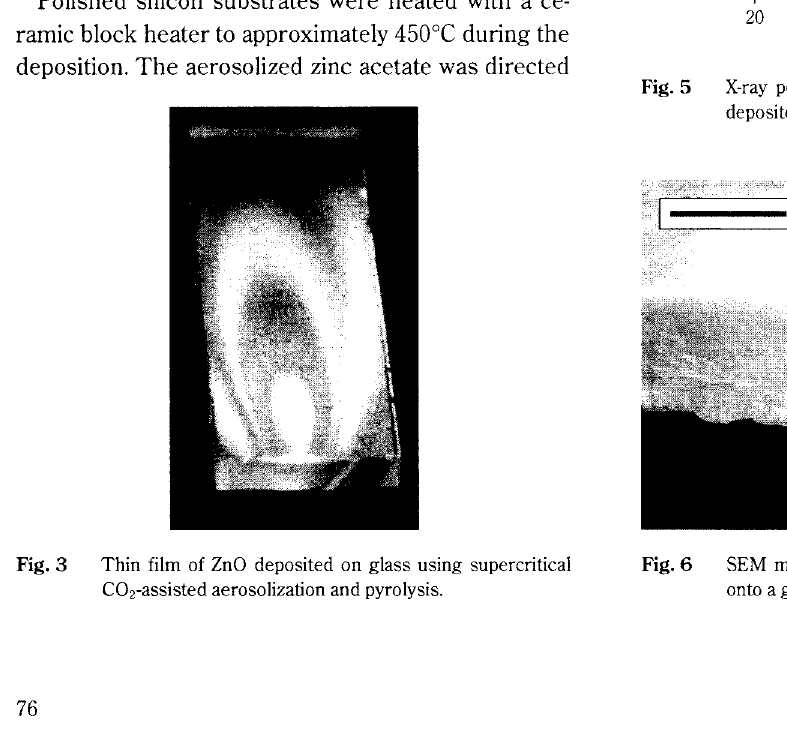
X-ray powder diffraction pattern for a thin film of ZnO deposited onto a silicon substrate.